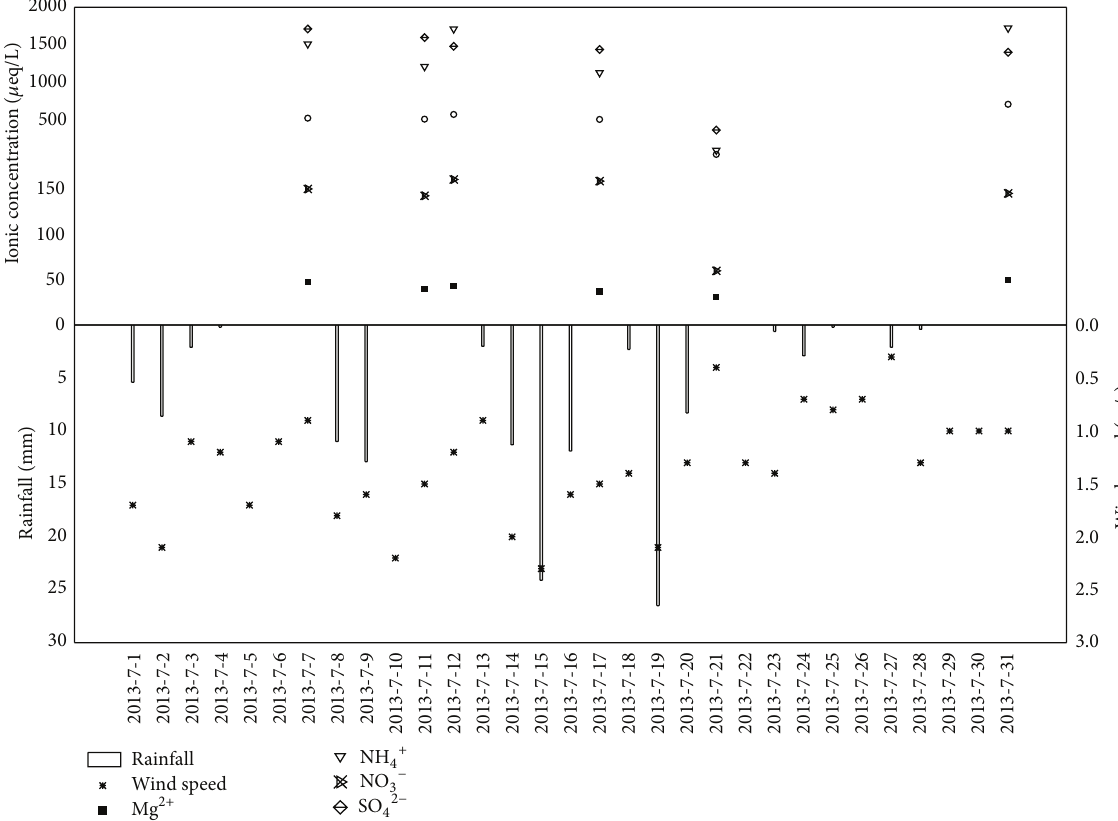
Figure 3: The ionic concentrations of dew, rainfall, and average wind speed during dew condensation for Changchun in July 2013.